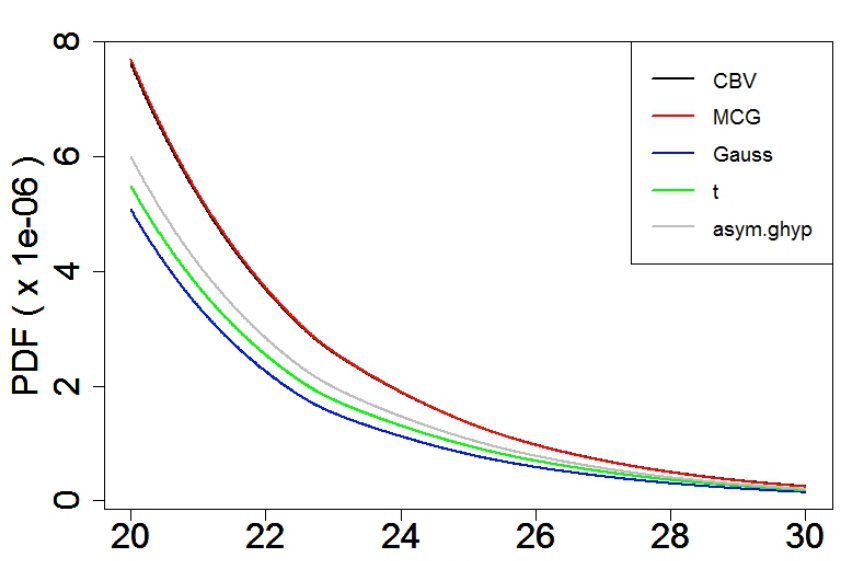
Fig. 9. Pdf (right tail) of portfolio loss distribution for several